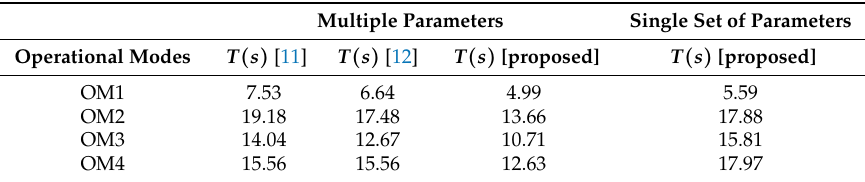
Table 13. Total operation time for each operational mode.